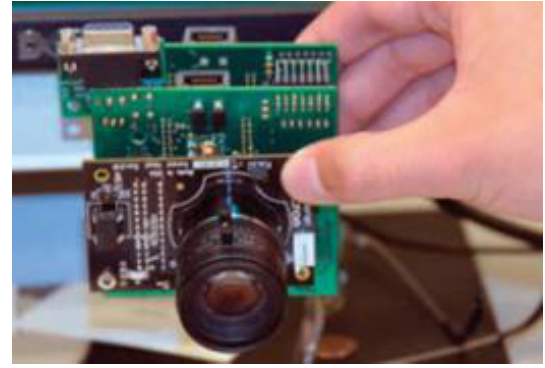
Figure 6: Cognitive Camera developed by a research team led by Penn State. The camera has an on-board computational power for intelligent video processing.